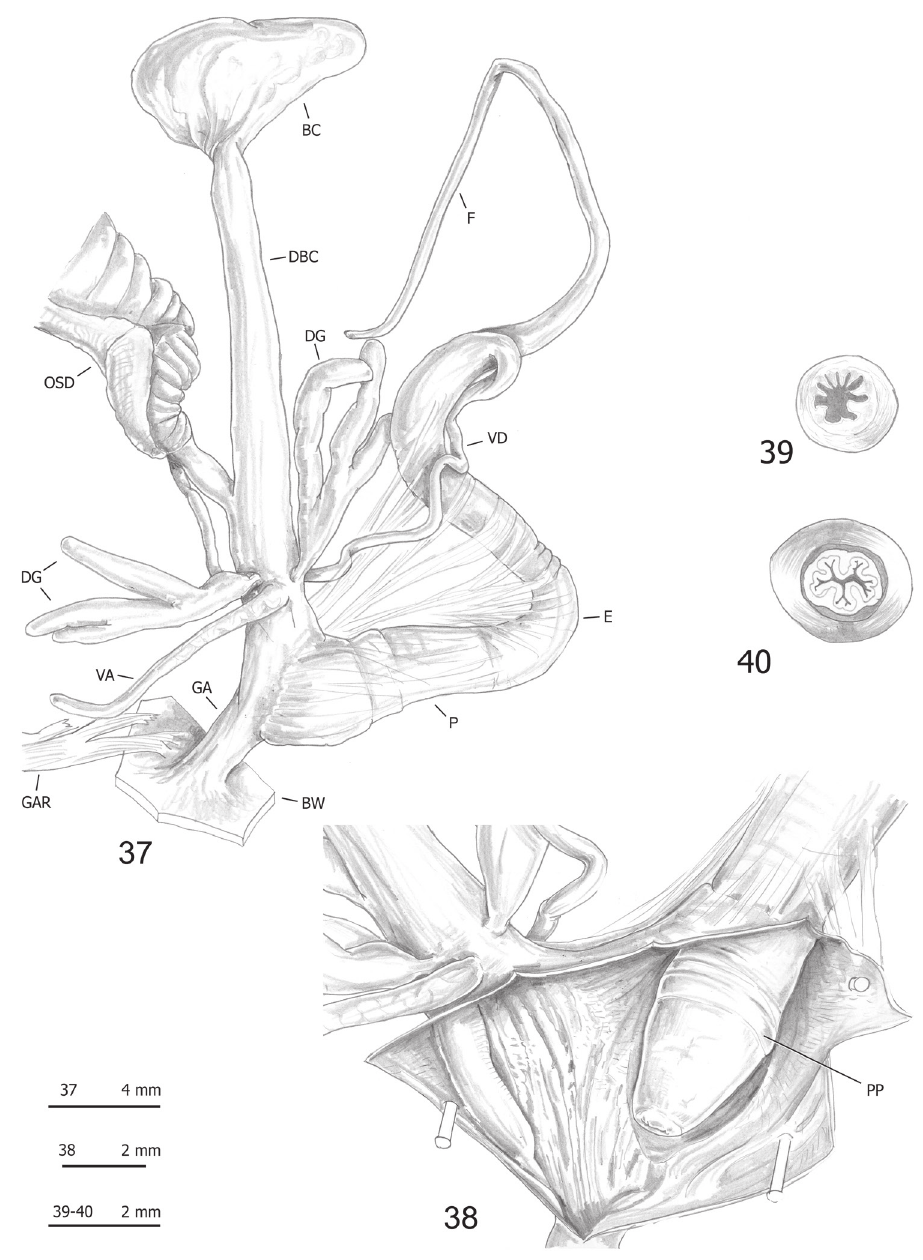
Figures 37–40. Genitalia (proximal parts excluded) ( 37 ), internal structure of distal genitalia ( 38 ), transverse sections of medial epiphallus ( 39 ) and apical penial papilla ( 40 ) of Monacha pantanellii from Monte Fionchi summit [Fio1] (FGC